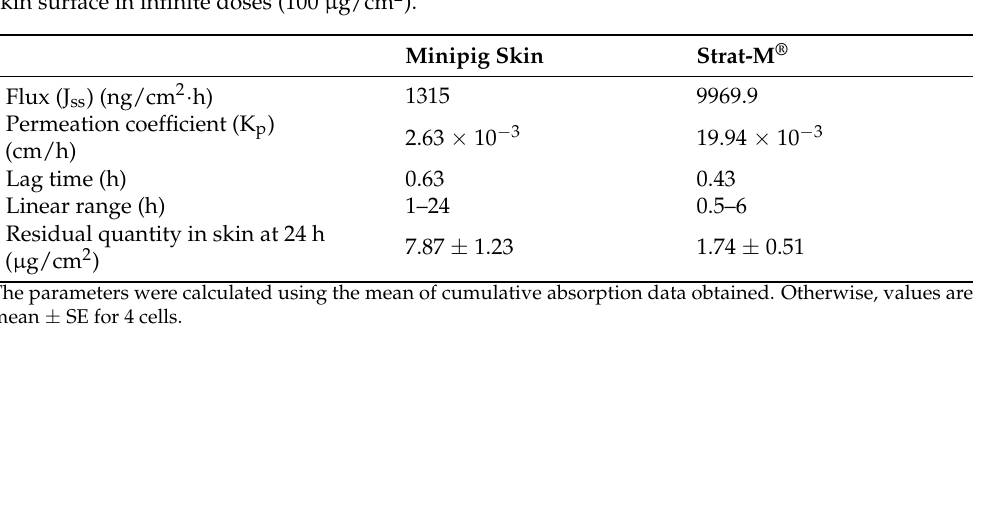
the minipig skin is more resistant to BIT penetration than the Strat-M ® . Table 2. Flux rates, permeation coefficients, lag times, and residual quantities of BIT applied to the skin surface in infinite doses (100 µ g/cm 2